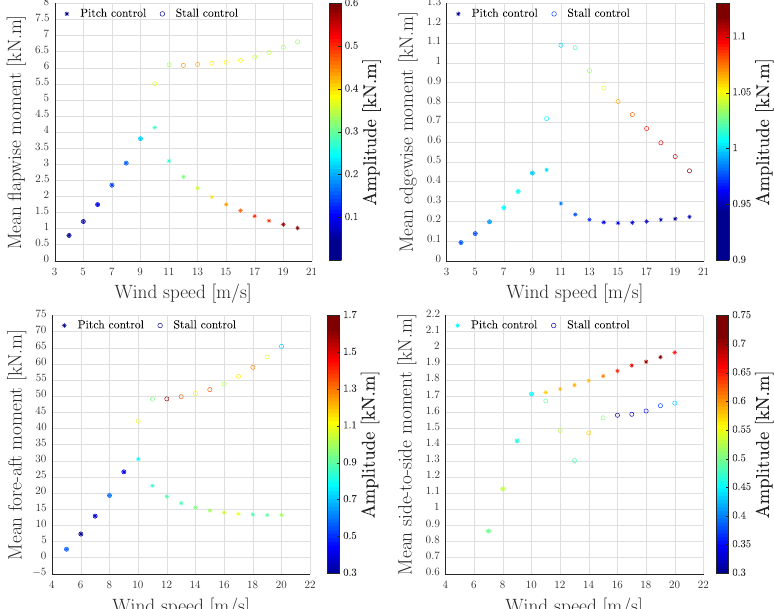
Figure 15. Comparison of the fatigue loads on the structure of the UAE wind turbine operating with pitch-to-stall and pitch-to-feather control in the whole wind speed